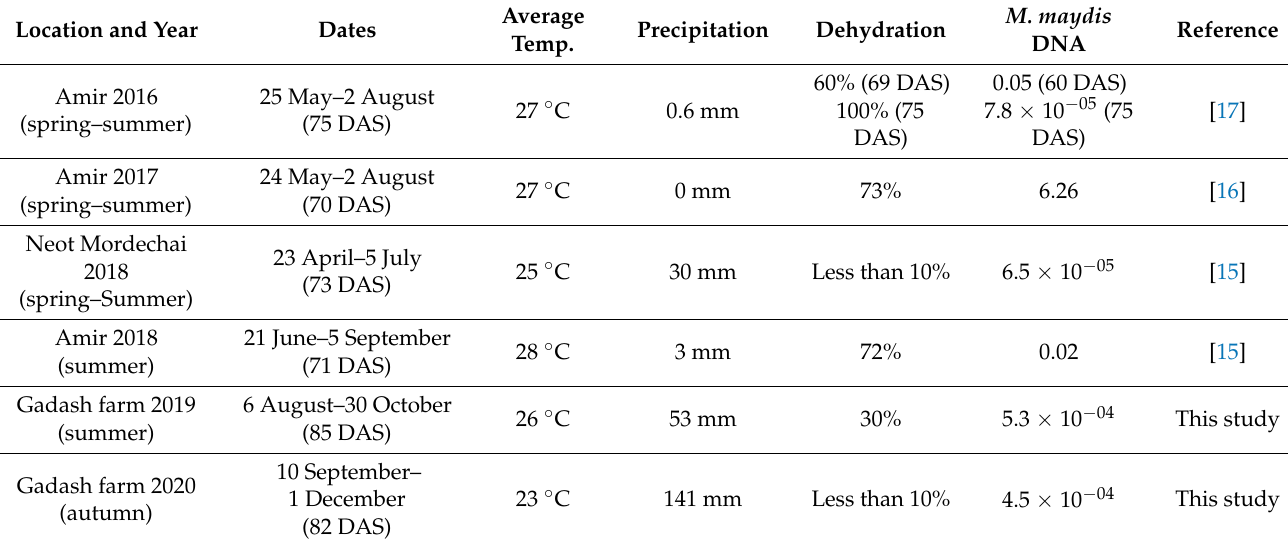
Table 7. Environmental conditions and maize late wilt disease in northern Israel in the growth seasons of 2016–2020 1